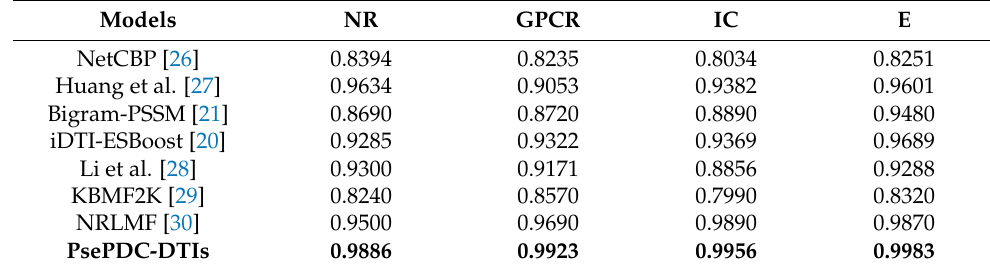
Table 1. Performance comparison of different approaches on benchmark datasets in terms of